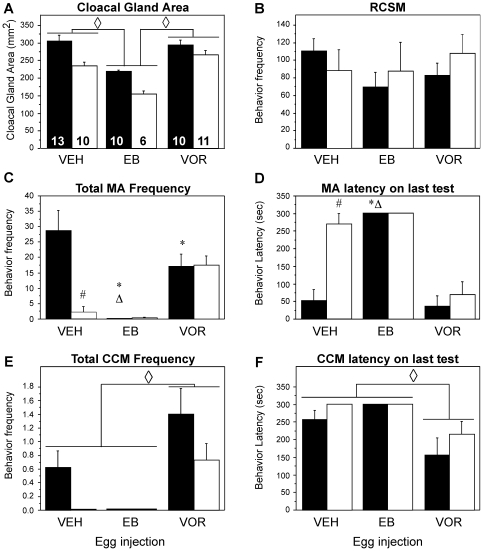
Effect of the embryonic treatments with estradiol benzoate (EB) or Vorozole (VOR) on the cloacal gland area and on different aspects of male sexual behavior of gonadectomized male (black bars) and female (white bars) quail that were treated as adults with exogenous testosterone.All data are means ± SEM. The number of subjects per group is indicated in bars of panel A. A. The cloacal gland area was significantly affected by the sex of the birds (F1,54 = 26.068; p<0.001) and their treatments (F2,54 = 27.798; p<0.001) but there was no interaction between these two factors (F2,54 = 1.836; p = 0.169). B. The frequency of female-elicited rhythmic contractions of sphincter muscles (RCSM) did not differ between sexes (F1,53 = 0.208; p = 0.650) or treatments (F2,53 = 0.493; p = 0.613) and was not influenced by the interaction of these two factors (F2,53 = 0.817; p = 0.447). C. The total frequency of mount attempts (MA) displayed during the 3 copulatory tests significantly differed between sexes (F1,54 = 5.879, p = 0.0187) and treatments (F2,54 = 7.989, p = 0.009) and an interaction between the 2 factors was detected (F2,54 = 6.808, p = 0.002). D. The mount attempt (MA) latency on the last copulatory test was also different between sexes (F1,54 = 12.104, p = 0.001) and treatments (F2,54 = 32.564, p<0.001) and a significant interaction was found (F2,54 = 8.464, p<0.001). E. The total frequency of cloacal contact movements (CCM) displayed during the 3 copulatory tests significantly differed between sexes (F1,54 = 5.106, p = 0.0279) and treatments (F2,54 = 10.975, p<0.001) and an interaction between the 2 factors was detected (F2,54 = 1.134, p = 0.329). F. The cloacal contact movements latency on the last copulatory test was also different between sexes (F1,54 = 1.895, p = 0.174) and treatments (F2,54 = 8.497, p<0.001) and a significant interaction was found (F2,54 = 0.449, p = 0.640). When appropriate, individual means were compared by Fisher Protected Least Significance Difference test. Results are reported at the top individual bars as follows: * p<0.05 compared to vehicle injection (VEH) same sex, Δ p<0.05 compared to Vorozole injection (VOR) same sex, # p<0.05 compared to males same treatment, and ◊ p<0.05 compared to other treatment in both sexes (no interaction in this analysis).